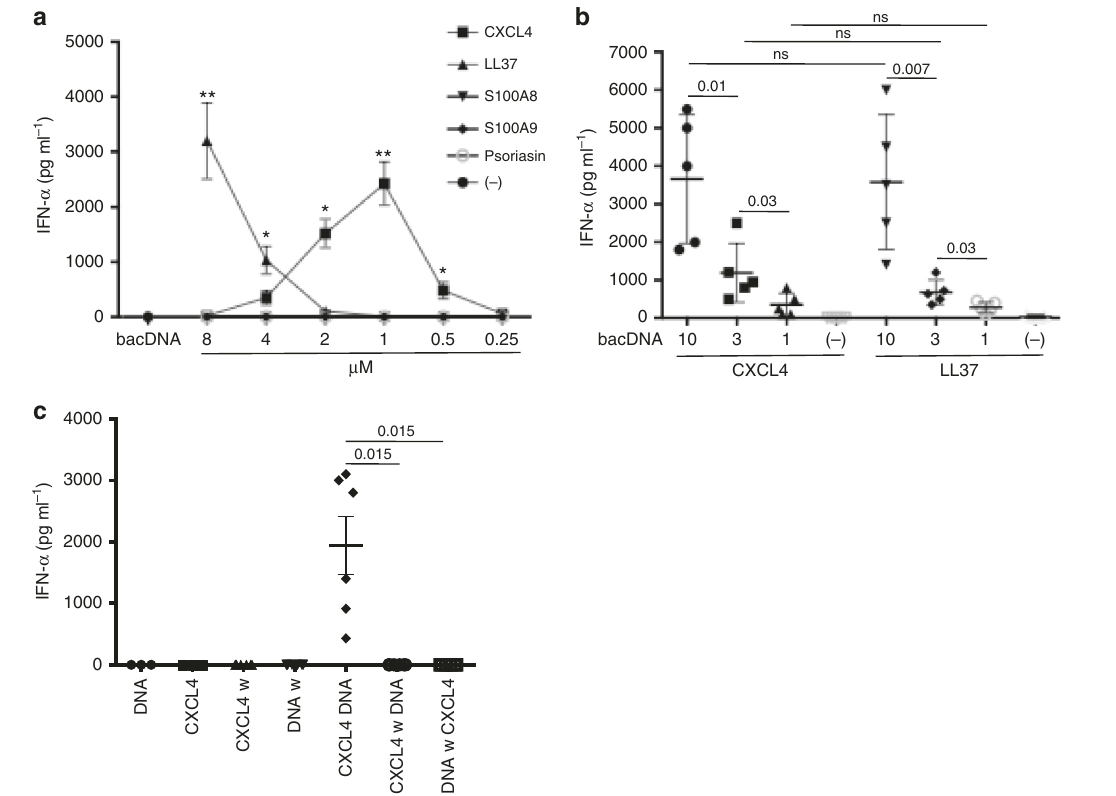
Fig. 3 CXCL4 – DNA complexes activate pDCs to produce IFN- α . a pDCs were stimulated with the indicated doses of CXCL4 or control molecules premixed with bacDNA (10 μ g ml − 1 ). IFN- α was measured after 24 h by ELISA. Data are shown as a mean±s.e.m. from fi ve independent experiments. * P -values < 0.05, ** P -values < 0.01 by Student ’ s t test for paired samples (two-tailed) are calculated with respect to IFN- α values obtained after stimulation of pDCs by bacDNA alone. b PDCs were stimulated with complexes made with fi xed concentrations of CXCL4 (1 μ M) or LL37 (10 μ M) and different doses of bacDNA ( μ g ml − 1 ). IFN- α was measured after 24 h by ELISA. Horizontal bars are the means, vertical bars are the s.e.m., P -values by Student ’ s t test for paired samples (two-tailed). c PDCs were stimulated with CXCL4 (1 μ M) – bacDNA (10 μ g ml − 1 ) complexes, or by CXCL4 or DNA alone (same concentration) for 3 h, then cells were extensively washed (w). Subsequently, the pDCs were stimulated with bacDNA or CXCL4 (as above), and IFN- α production was measured by ELISA. Horizontal bars are the means, vertical bars are s.e.m., P -values by Student ’ s t test for paired samples